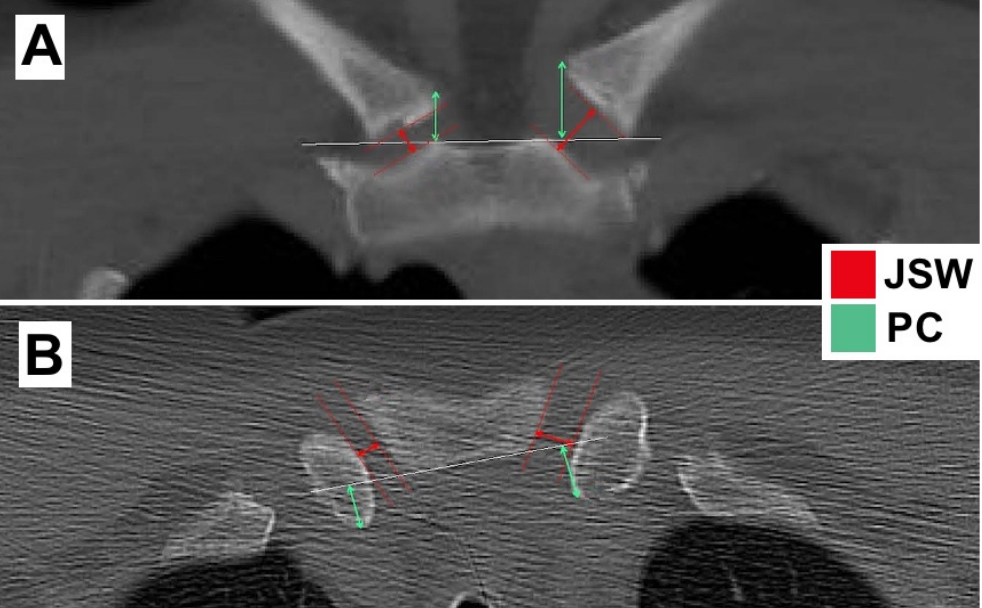
Figure 1. ( A , B ). CT scan in coronal ( A ) and axial ( B ) plane for measurement of the joint space width JSW (red) and position of medial clavicle PC (green). The JSW was determined by the least distance between the clavicle and sternal corticalis. PC, in contrast, was determined by the distance between the apical sternal corticalis and the apical end of the medial clavicle in the coronal plane, and by the posterior corticalis of the sternum and the posterior end of the medial clavicle in the axial plane.